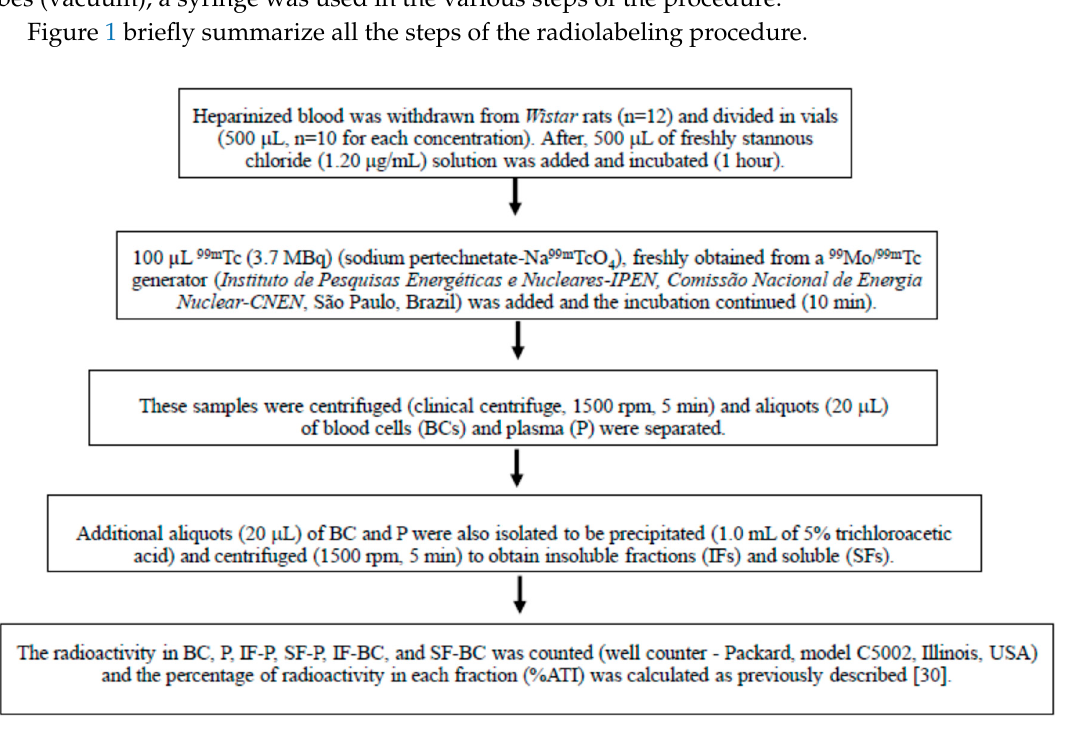
Figure 1. The 99m Tc (99m-technetium) labeling of blood constituents withdrawn from Wistar rats.